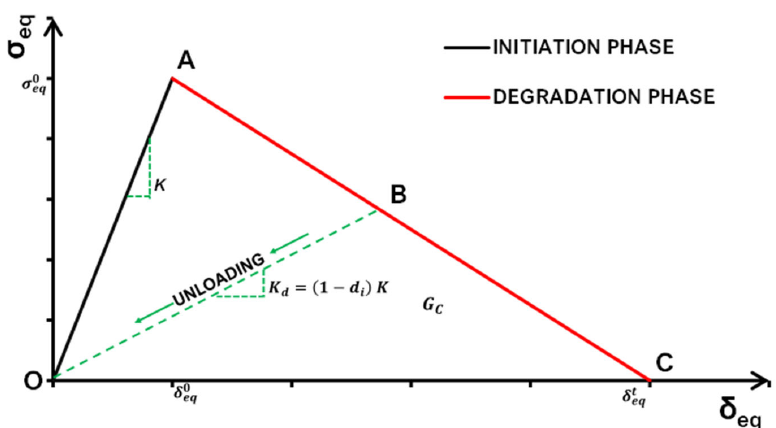
Figure A1. Damage constitutive relation.